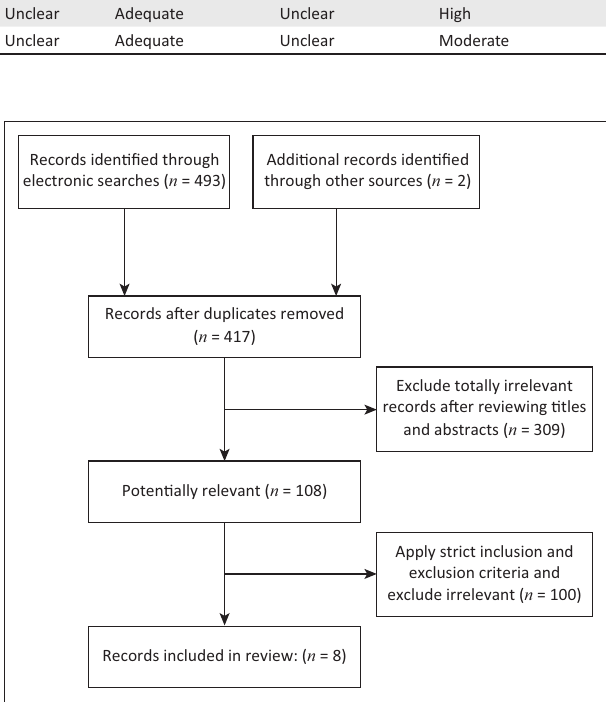
FIGURE 1: Flow diagram for systematic review process.